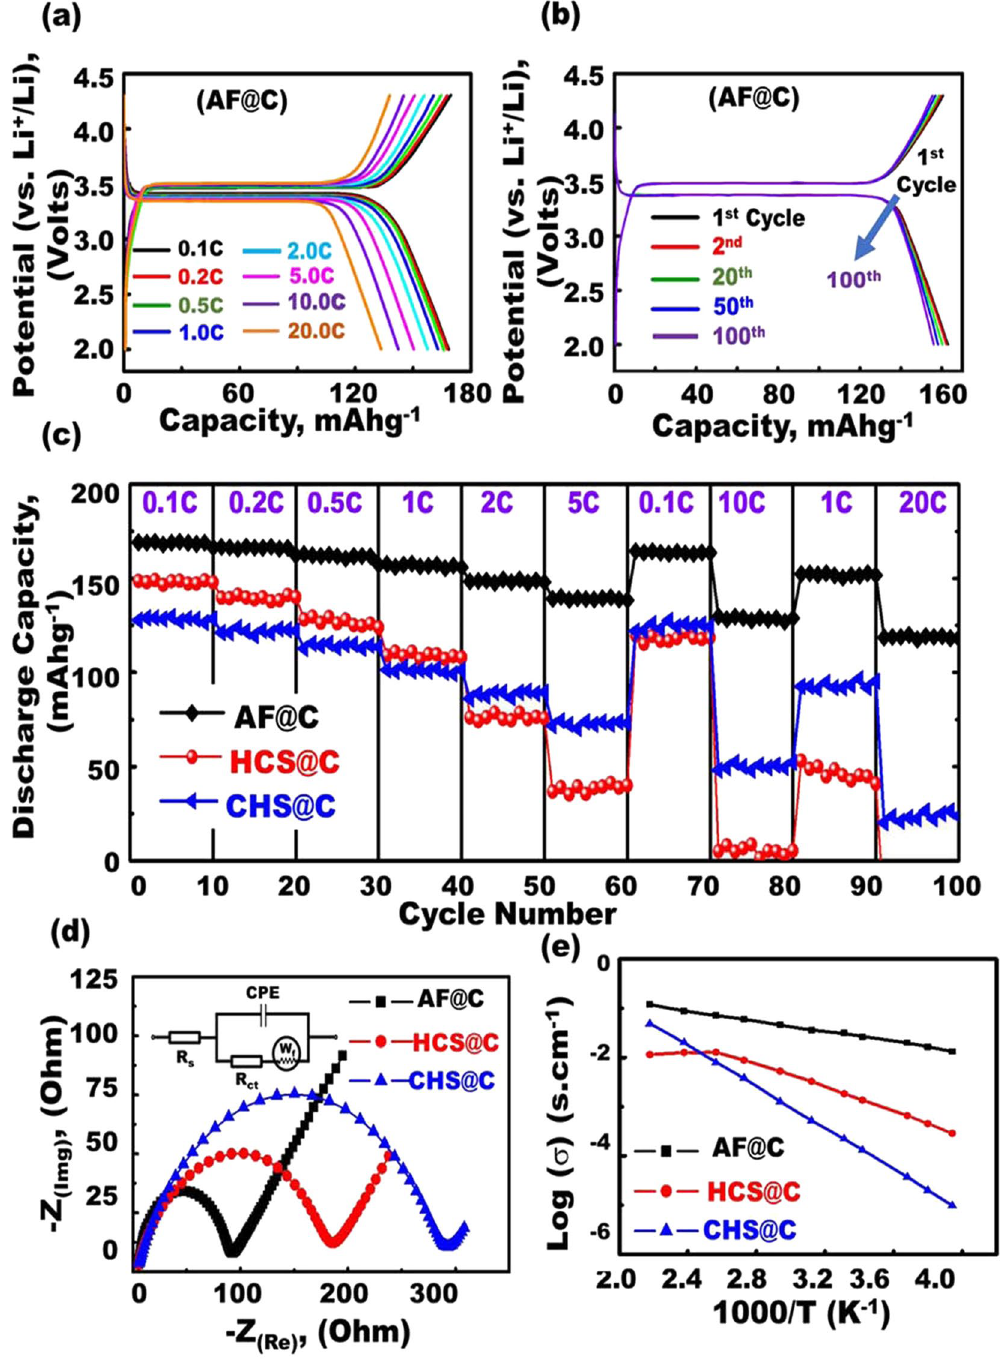
Figure 5. ( a ) First-cycle half-cell AF@C cathode at different current rates from 0.1 C to 20 C. ( b ) AF@C cathode material as a half-cell at a current rate of 1.0 C at different cycles up to 100 cycles. ( c ) Rate capability performance rates of different geodesic LFPO cathodes, such as AF@C with convex spheres and serrated cuticles, HCS@C, and CHS@C, over a range of 2.0–4.3 V and at various current rates from 0.1 C to 20 C. ( d ) EIS results for the